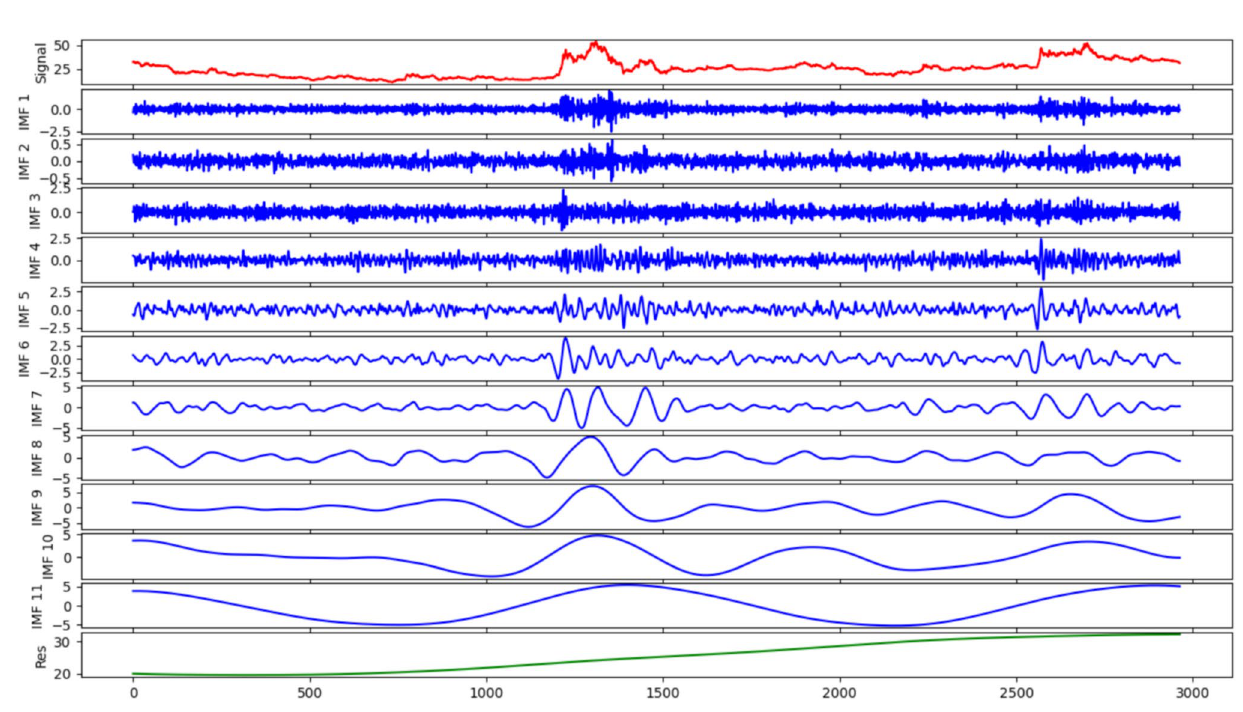
Fig. 6 The decomposition results of CEEMD for